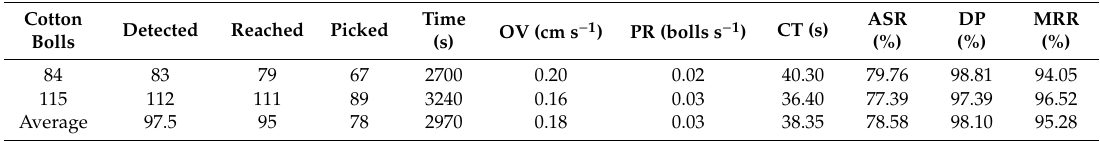
Table 3. The collected data for the experiments done to validate the performance of the system in the real field